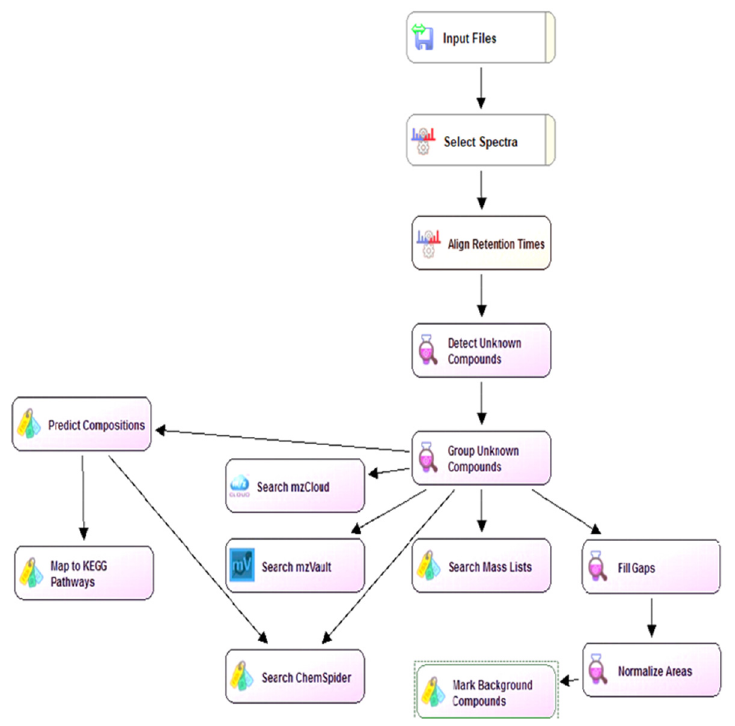
Figure 9. A flowchart showing the customized untargeted metabolomics workflow used in this study.